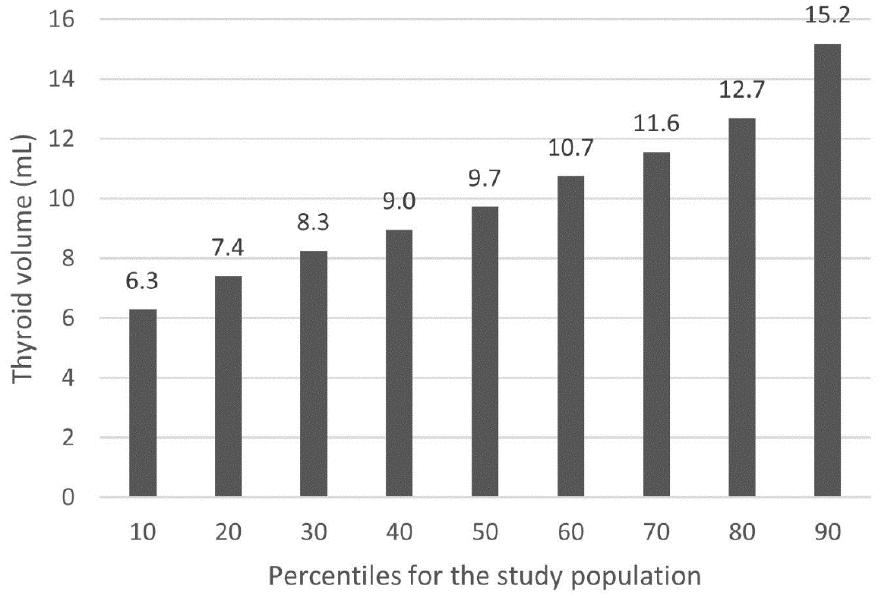
Figure 1. Percentiles of the thyroid volume for the study population. Table 2. Correlations between the thyroid volume and the thyroid function.